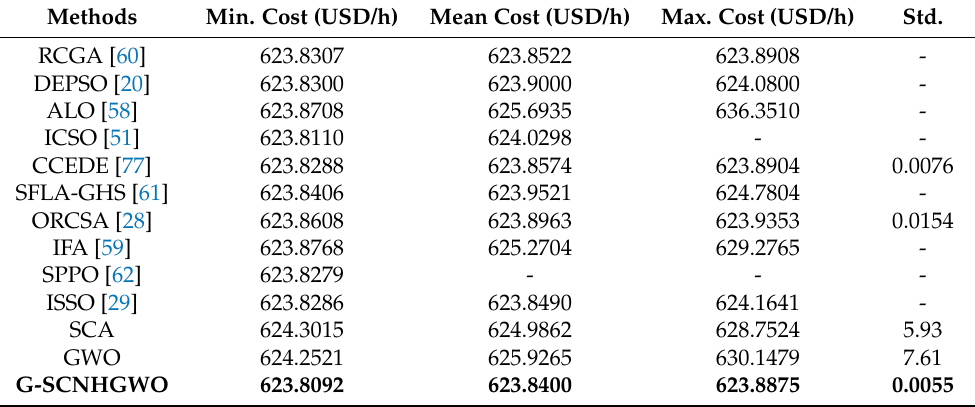
Table 1. The statistical indices of optimal results obtained by different methods for Case A-type 1.